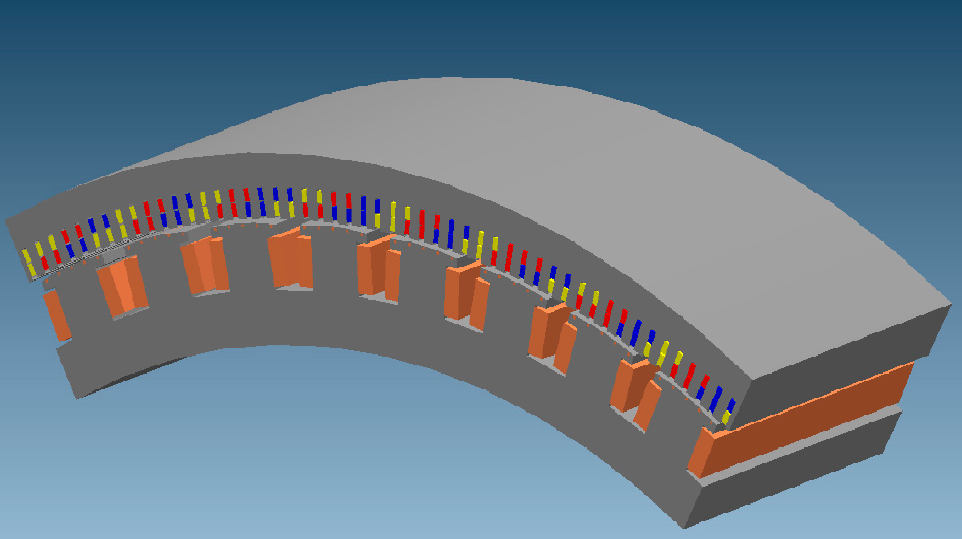
Figure 1. A solid model of 8 poles of an analyzed hydro generator. The model includes stator and rotor. Stator is made of non-skewed slots with three- phase winding conductors in a laminated core. Rotor poles are mounted on a steel hub and made of steel laminations. Excitation winding coils are placed around the poles, and they are comprised of copper wires. Five holes are in the pole shoes, where round copper bars are inserted, creating the damping winding. Damper winding slots are closed.